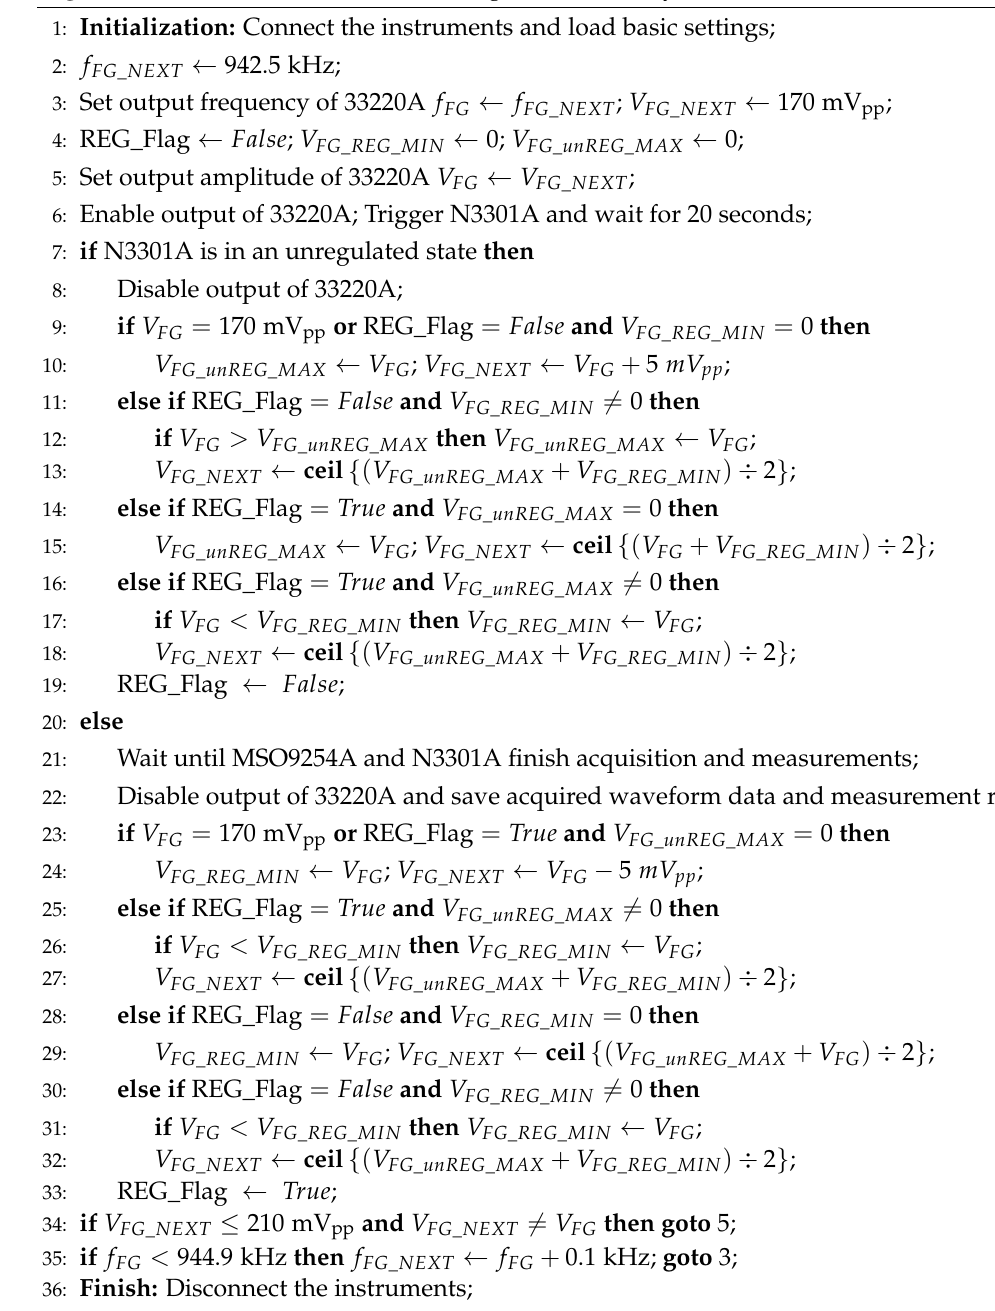
Algorithm 1 Automated measurement algorithm of the